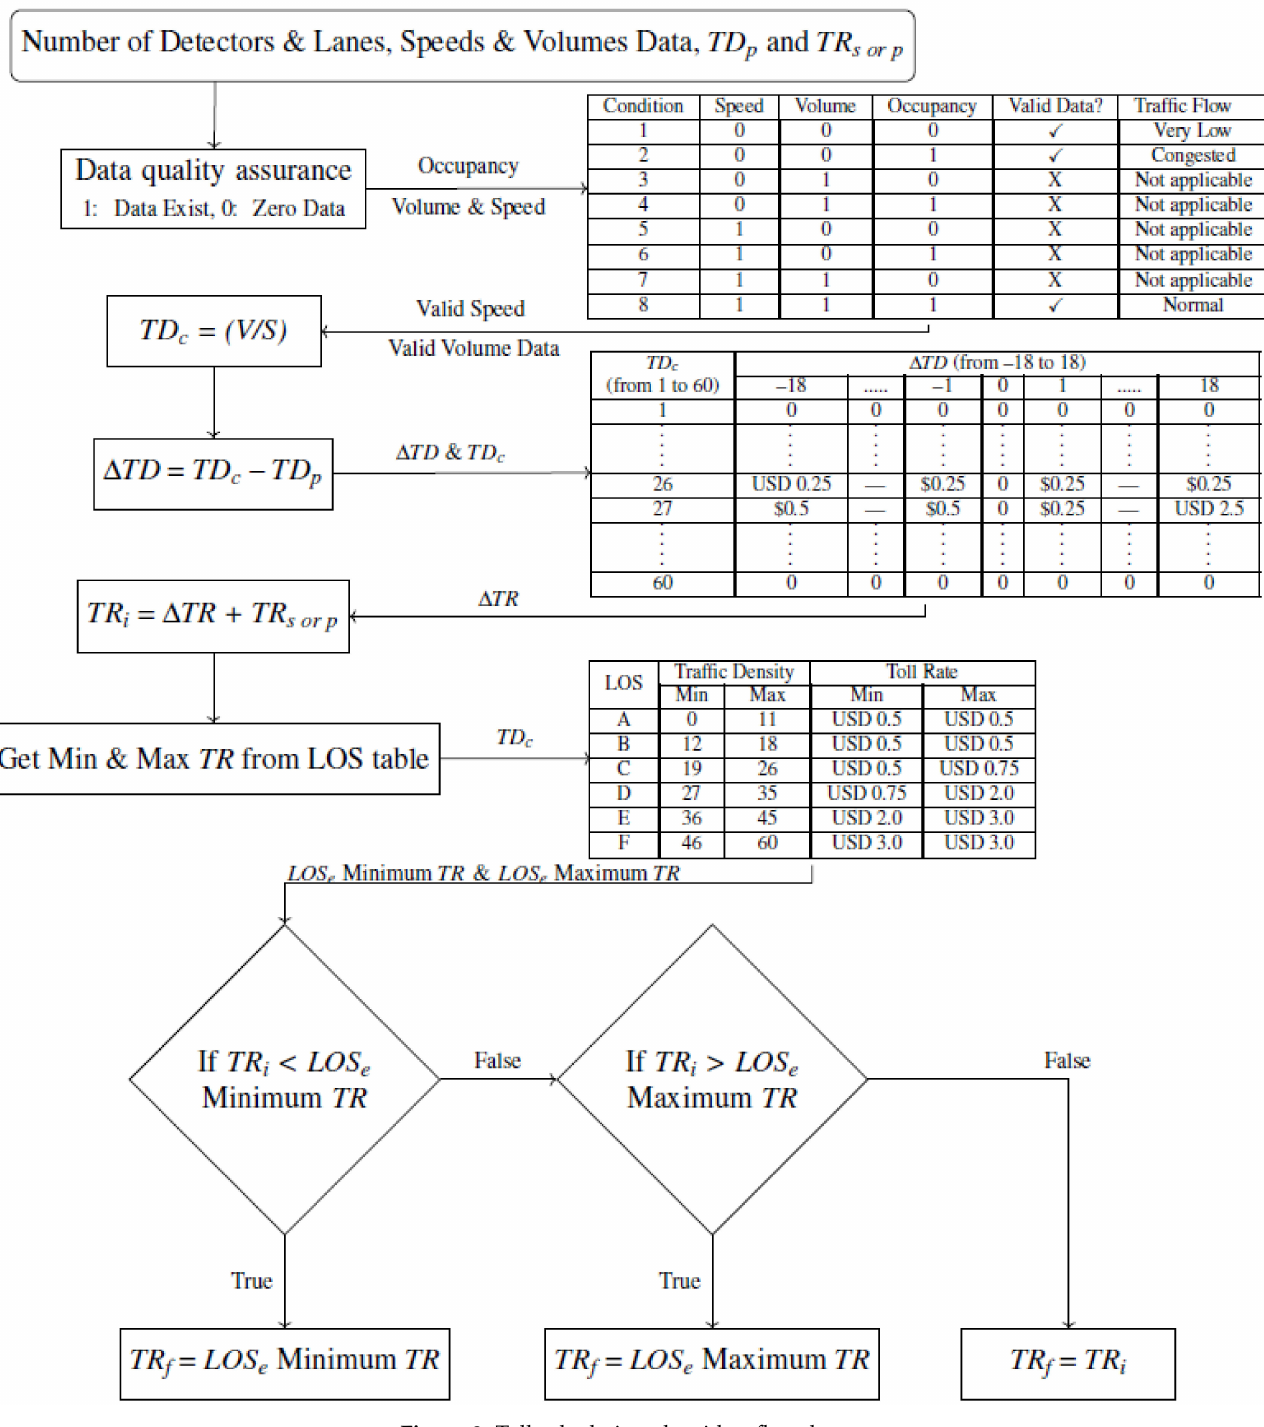
Figure 3. Toll calculation algorithm